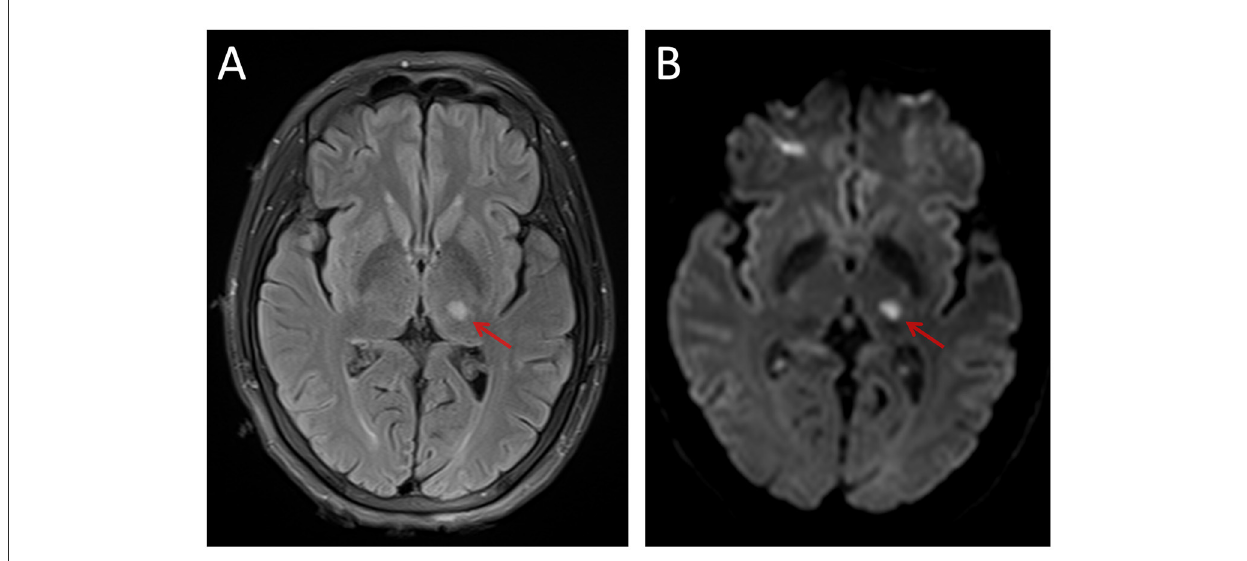
FIGURE1 An example of the left thalamic infarct on FLAIR (A) and DWI (B) . FLAIR, fluid-attenuated inversion recovery; DWI, diffusion-weighted